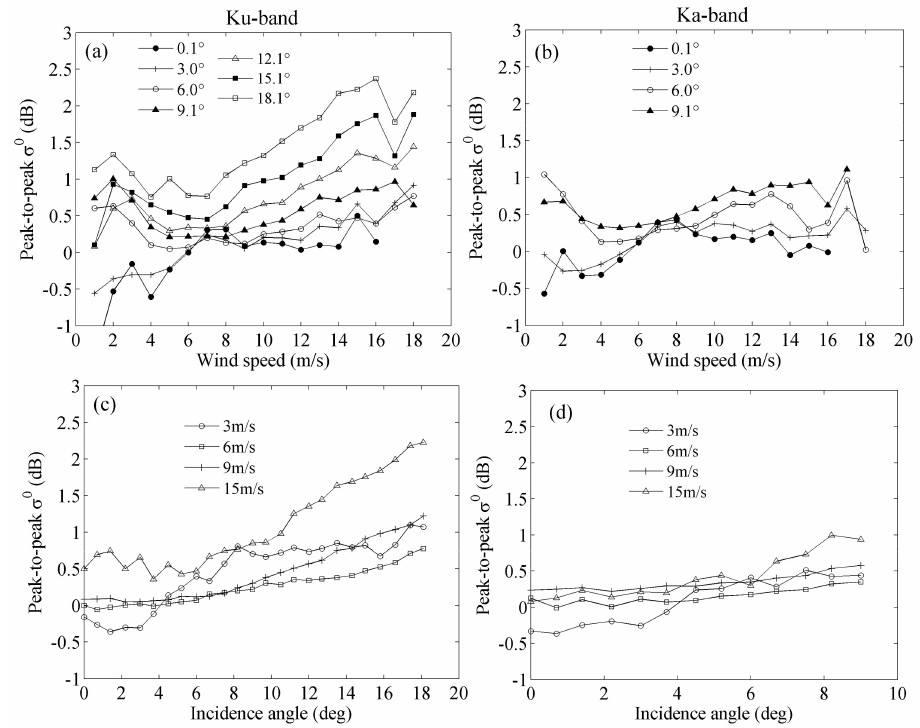
Figure 8. Estimates of peak-to-peak σ 0 as functions of ( a ) and ( b ) wind speed for different incidence angles, ( c ) and ( d ) incidence angle for different wind speeds. ( a ) and ( c ) for KuPR, ( b ) and ( d ) for